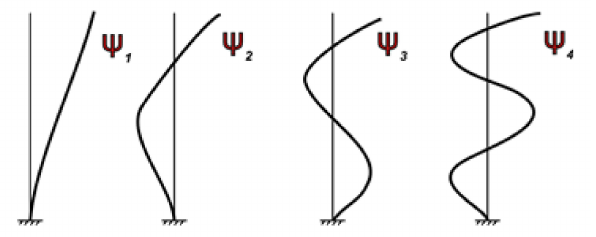
Figure 10. First four eigen modes of a cantilever